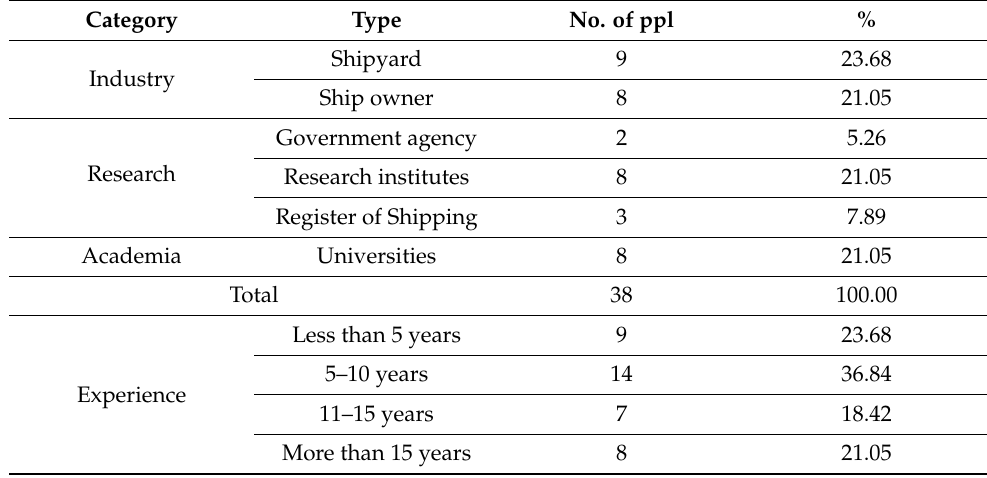
Table 5. Statistics of survey respondents’